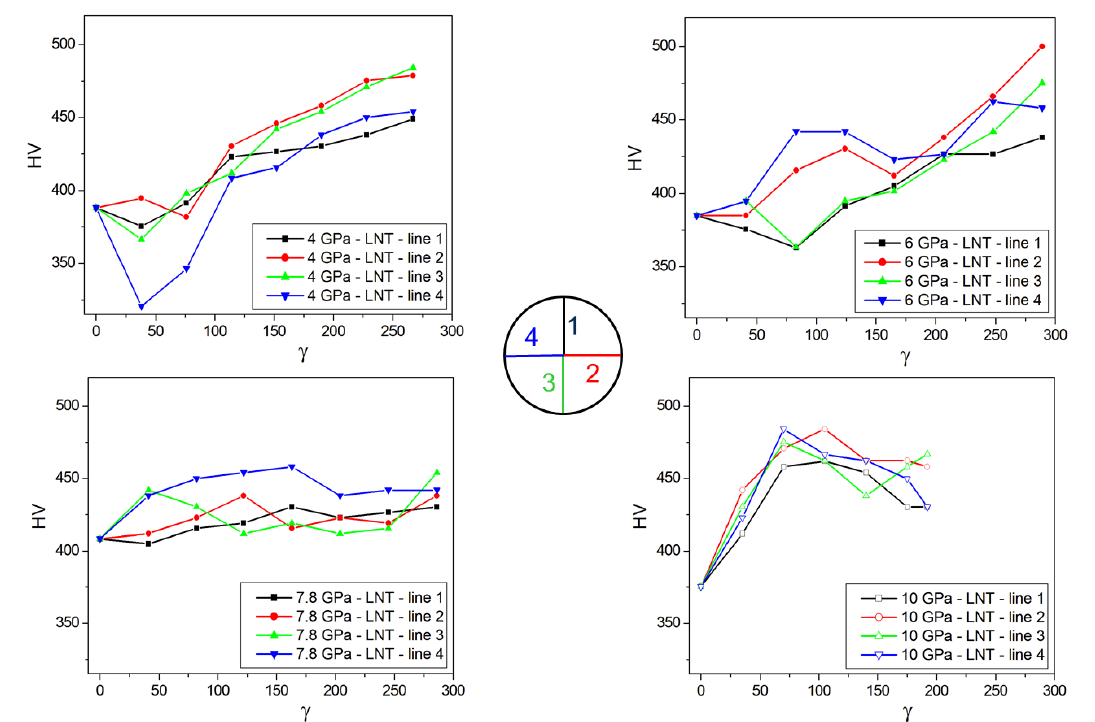
Figure 14. Microhardness measured at RT of samples HPT-deformed at RT ( a ) and LNT ( b ) versus shear strain γ .